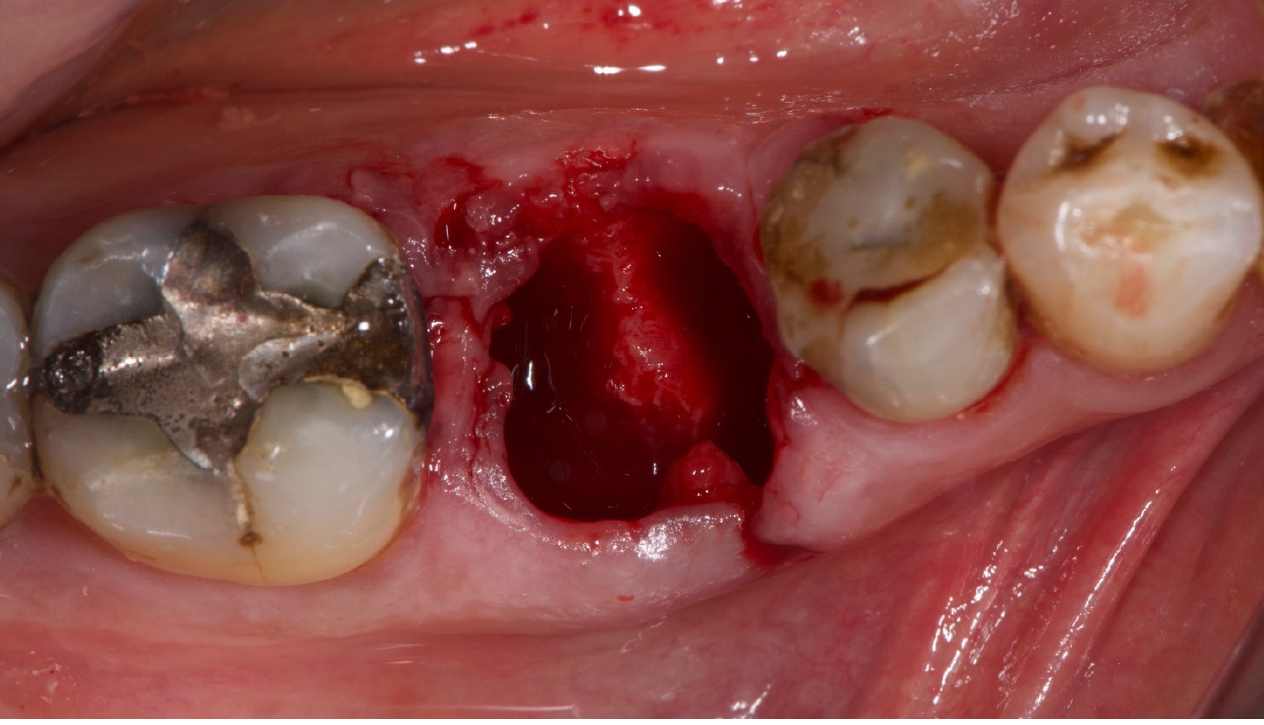
Figure 2. Atraumatic tooth extraction.